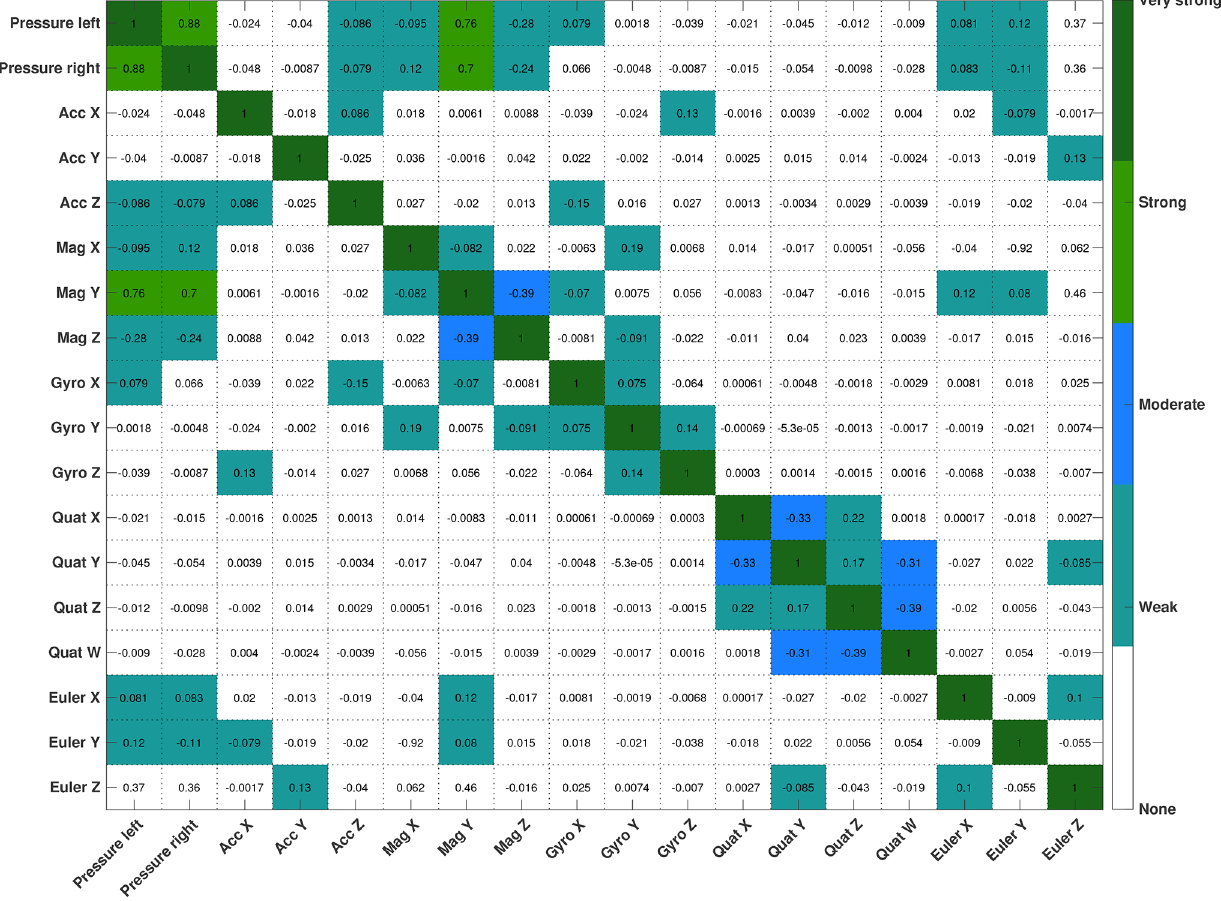
Figure 4. Pearson product-moment correlation coefficients ( r ) between the different sensor readings for all deployments ( n = 40). The classification is adapted following Cohen